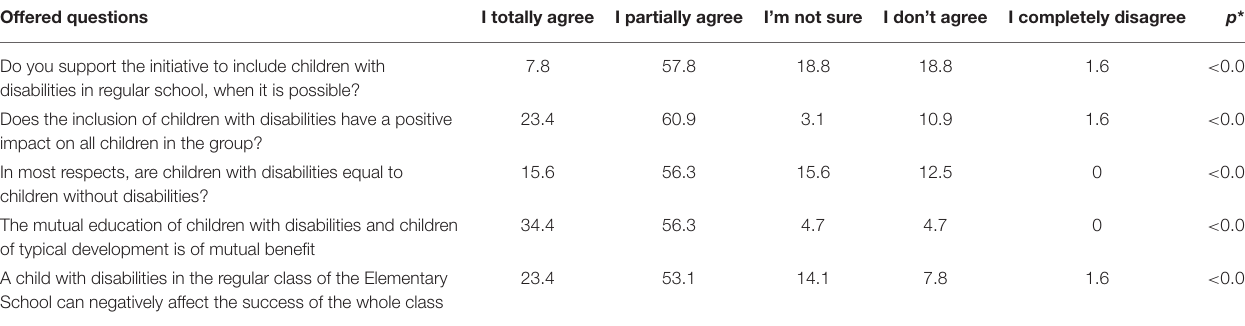
TABLE 2 | Attitudes of primary school teachers toward children with